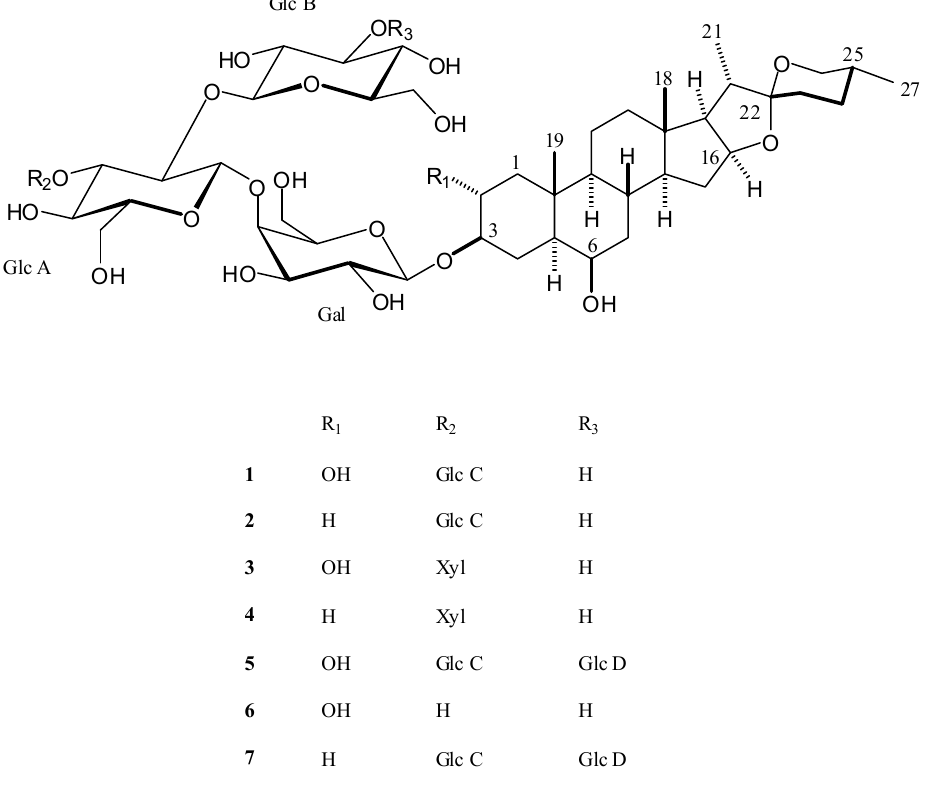
Figure 1 . The structures of the steroidal saponins isolated from A. leucanthum